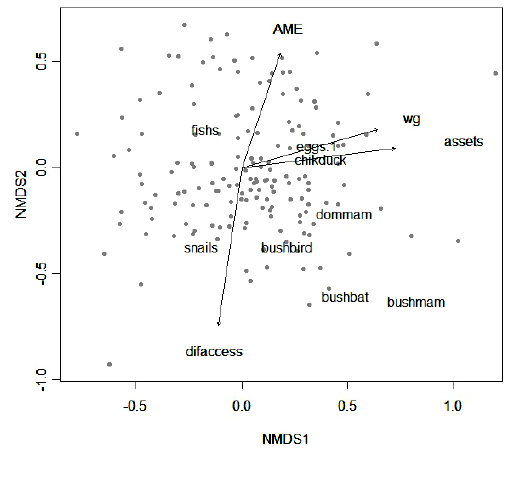
Fig. 5 . Nonmetric multidimensional scaling (NMDS) ordination of average consumption frequencies of animal food items per household (Stress = 0.18), with the scores of each species on ordination axes indicated by its position on the diagram. The grey dots on the back are the households, distributed in the diagram based on their average consumption of each food type. The arrows represent the fitted variables for household’s socioeconomic characterization: AME (number of adult male equivalents at the household), wg (wealth group), assets (average number of listed assets of the household), and difaccess (inaccessibility index). These were the significant variables (p max = 0.05) identified from a larger introduced